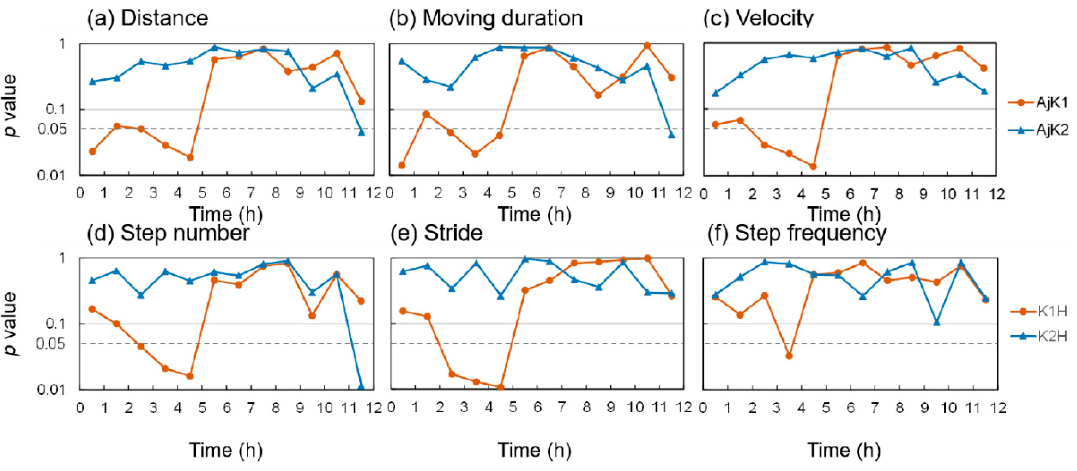
Figure 3. Significance of differences between different neuropeptide groups changed over time: ( a ) distance; ( b ) moving duration; ( c ) velocity; ( d ) step number; ( e ) stride length; ( f ) step frequency. ( a – c ) show the difference between different dose levels (0/L/M/H) of K1 (or K2), which were compared by one-way ANOVA. ( d – f ) The difference between the two high concentration treatment groups (K1H and K2H) and the seawater control group, which were compared using t -tests (two- tailed). The significance level was set at 0.05.